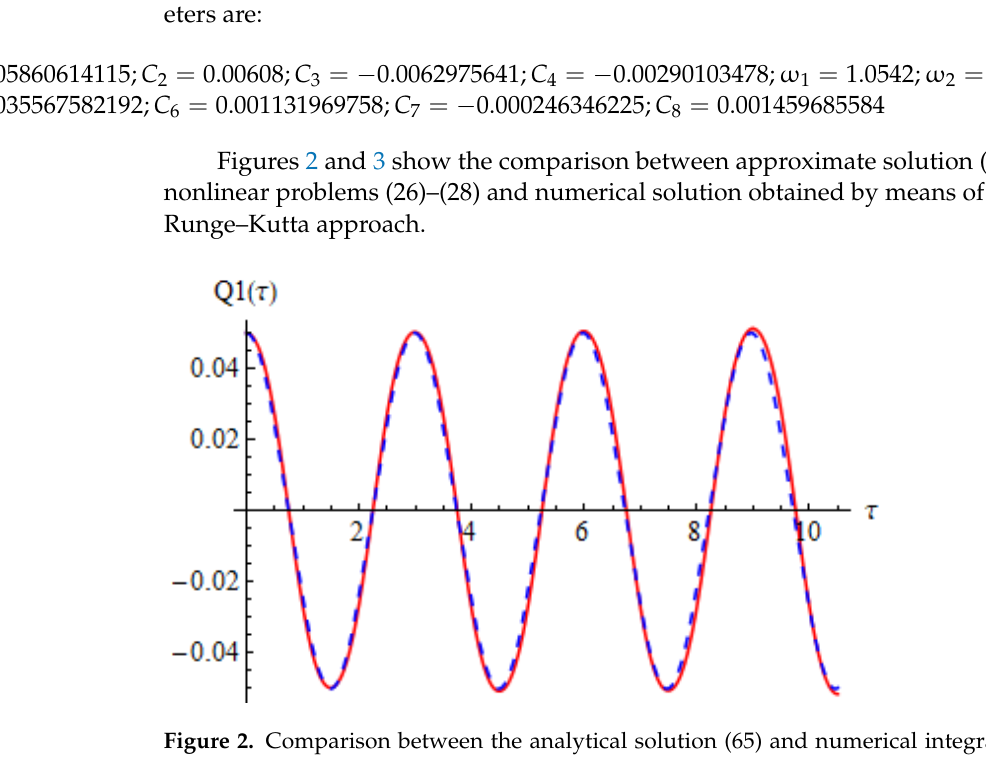
Figure 3. Comparison between the analytical solution (66) and numerical integration results for Equation (27): red solid line depicts numerical integration results while blue dashed line depicts analytical results. It can be seen that the two solutions obtained by means of OAFM are nearly identical to the numerical integration results. 6. Stability Analysis The dynamic behavior of the DWCNT system considering mechanical impact and embedded on Winkler–Pasternak foundation is investigated through homotopy pertur- bation method [32]. This approach predicts limits of instability in the case of primary res- onance 4,4 31 ≈≈ dd